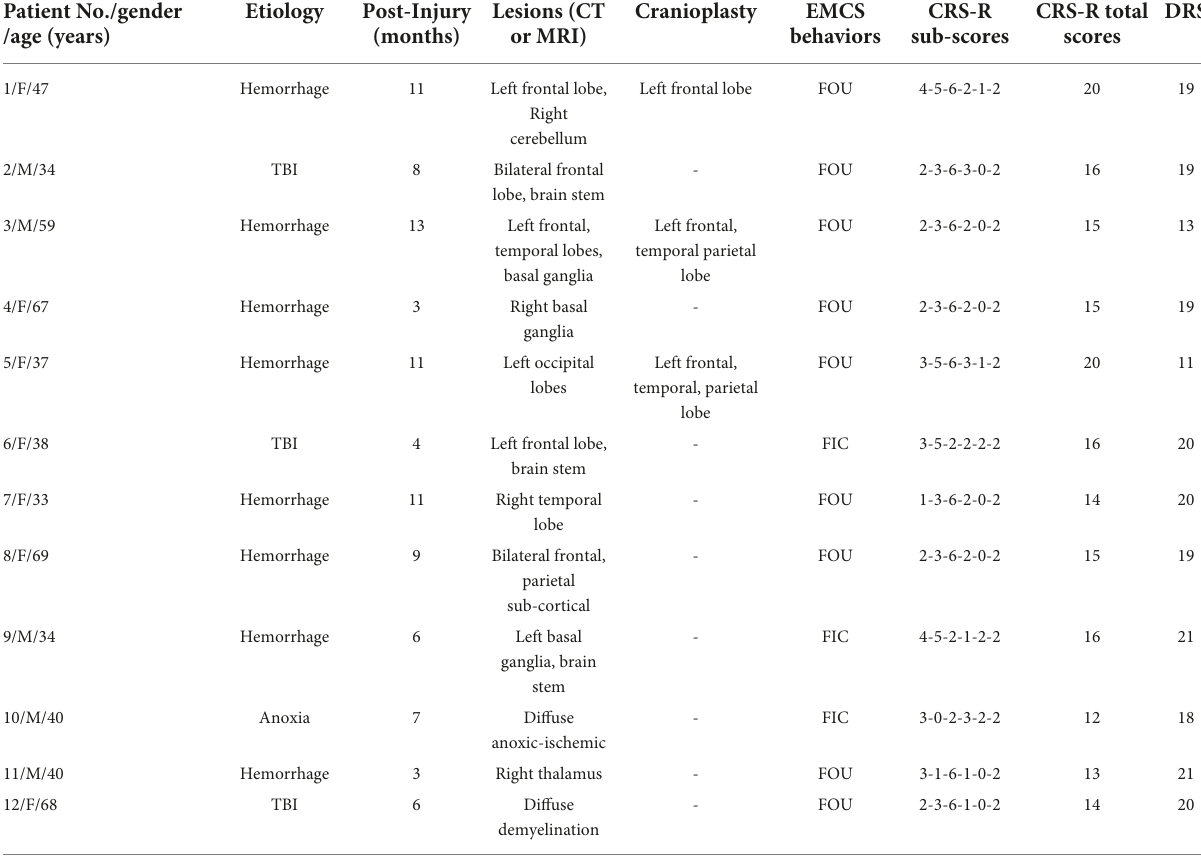
TABLE 1 Patients’ demographic